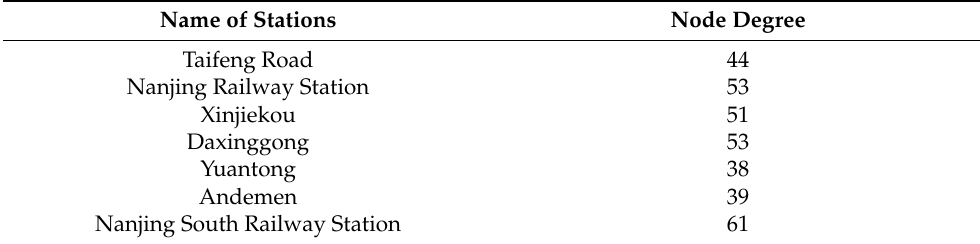
Table 1. Node degree of space P in the Nanjing rail transit